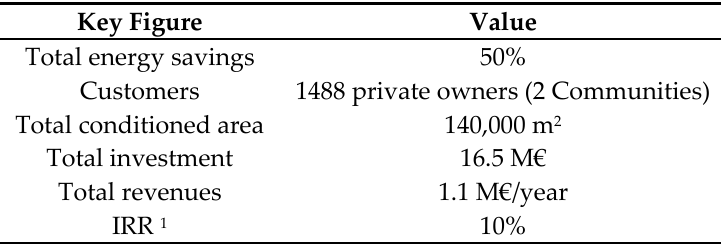
Table 5. Key figures for Torrelago business